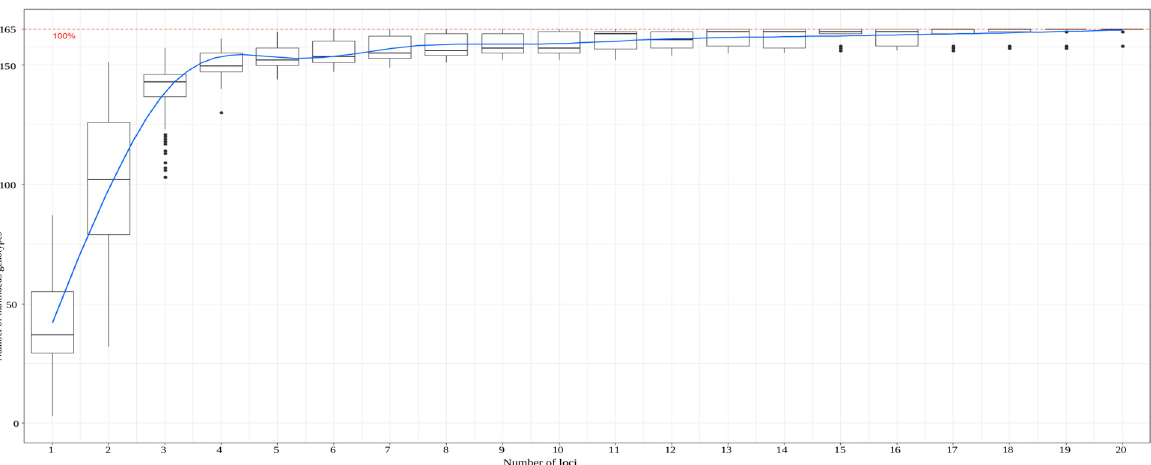
Figure 2. The minimum number of microsatellite markers needed to differentiate distinct accessions, determined using an accumulation curve calculated in the poppr package within R.